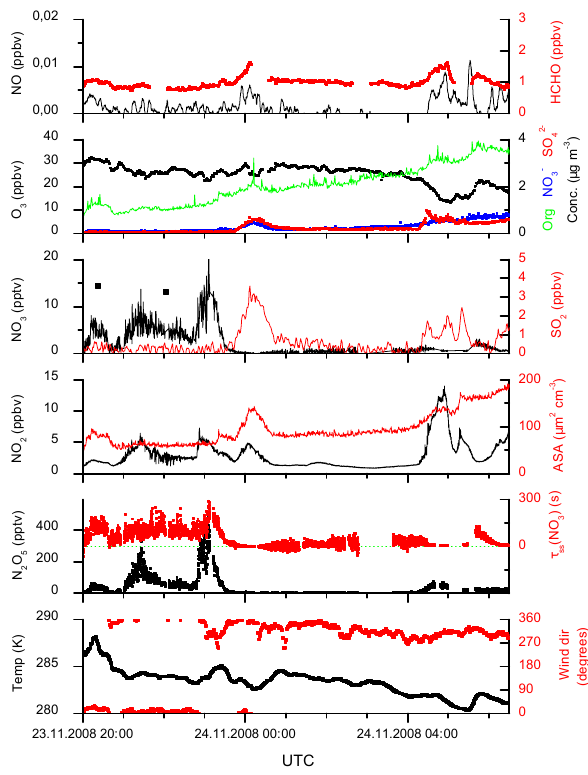
Fig. 7. Overview of measurements on the night 23rd–24th in which wind direction swung from the continental to Huelva sector. Only limited LP-DOAS measurements (solid black symbols) were avail- able from the lowest optical path on this